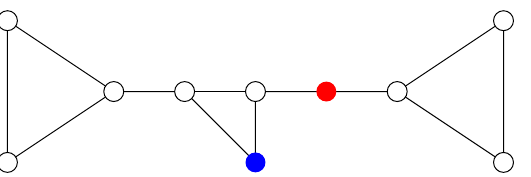
Figure 2. A graph with two different stalling sets of size 1. The blue vertex represents one stalling set and the red vertex represents another stalling